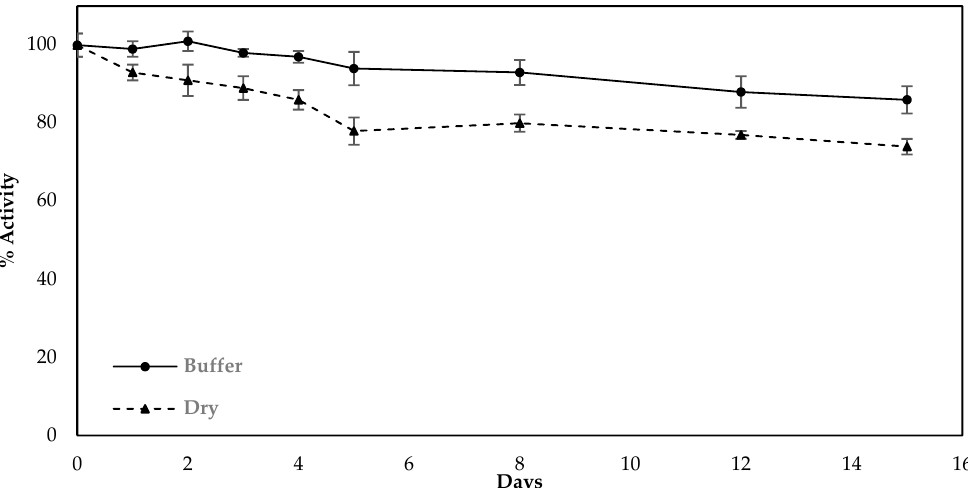
Figure 8. Decrease in activity of the sensors fabricated following the optimized protocol and upon storage at different conditions (dry or in buffer solution at 4 °C). The percentage decrease was calculated from the current recorded upon the interrogation of the sensors with freshly prepared substrate and how this compared with the current recorded when the sensors were interrogated as prepared. All measurements were taken in triplicate.